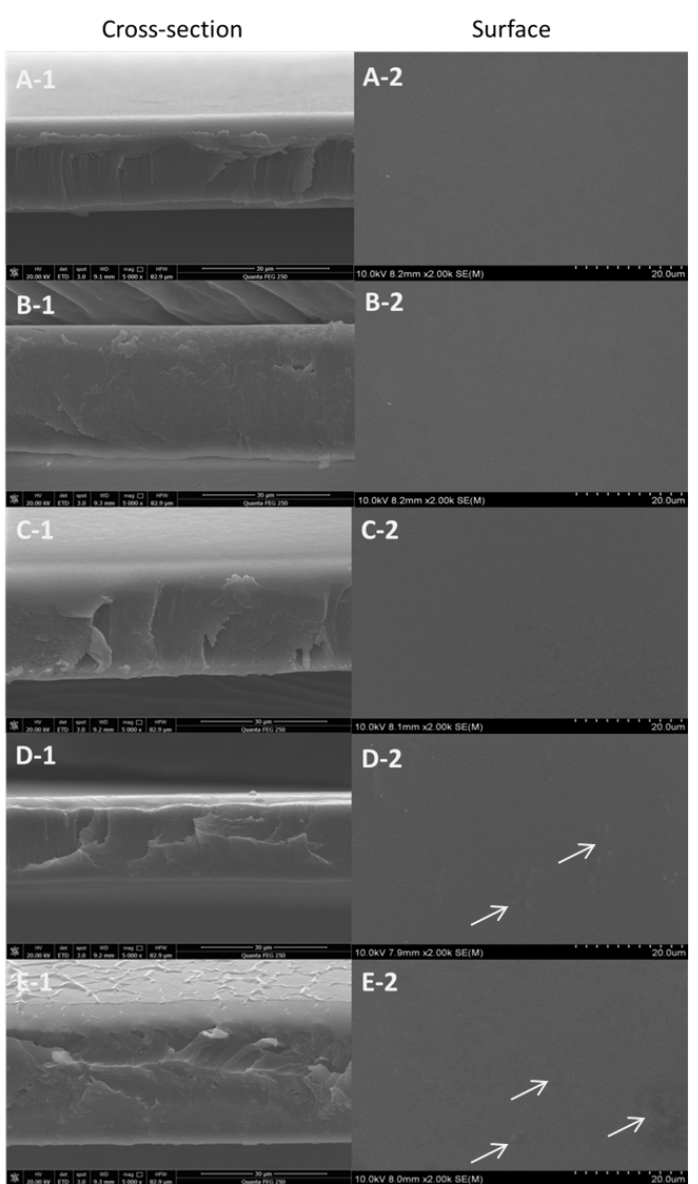
Figure 3. Scanning electron microscopy (SEM) images of the surface ( A-1 )–( E-1 ) and cross section ( A-2 )–( E-2 ) of composite films. ( A-1 ) and ( A-2 ) GEL/CS films; ( B-1 )–( E-1 ) and ( B-2 )–( E-2 ) GEL/CS/Cur films with Cur contents of 0.025, 0.05, 0.1, and 0.2, respectively.